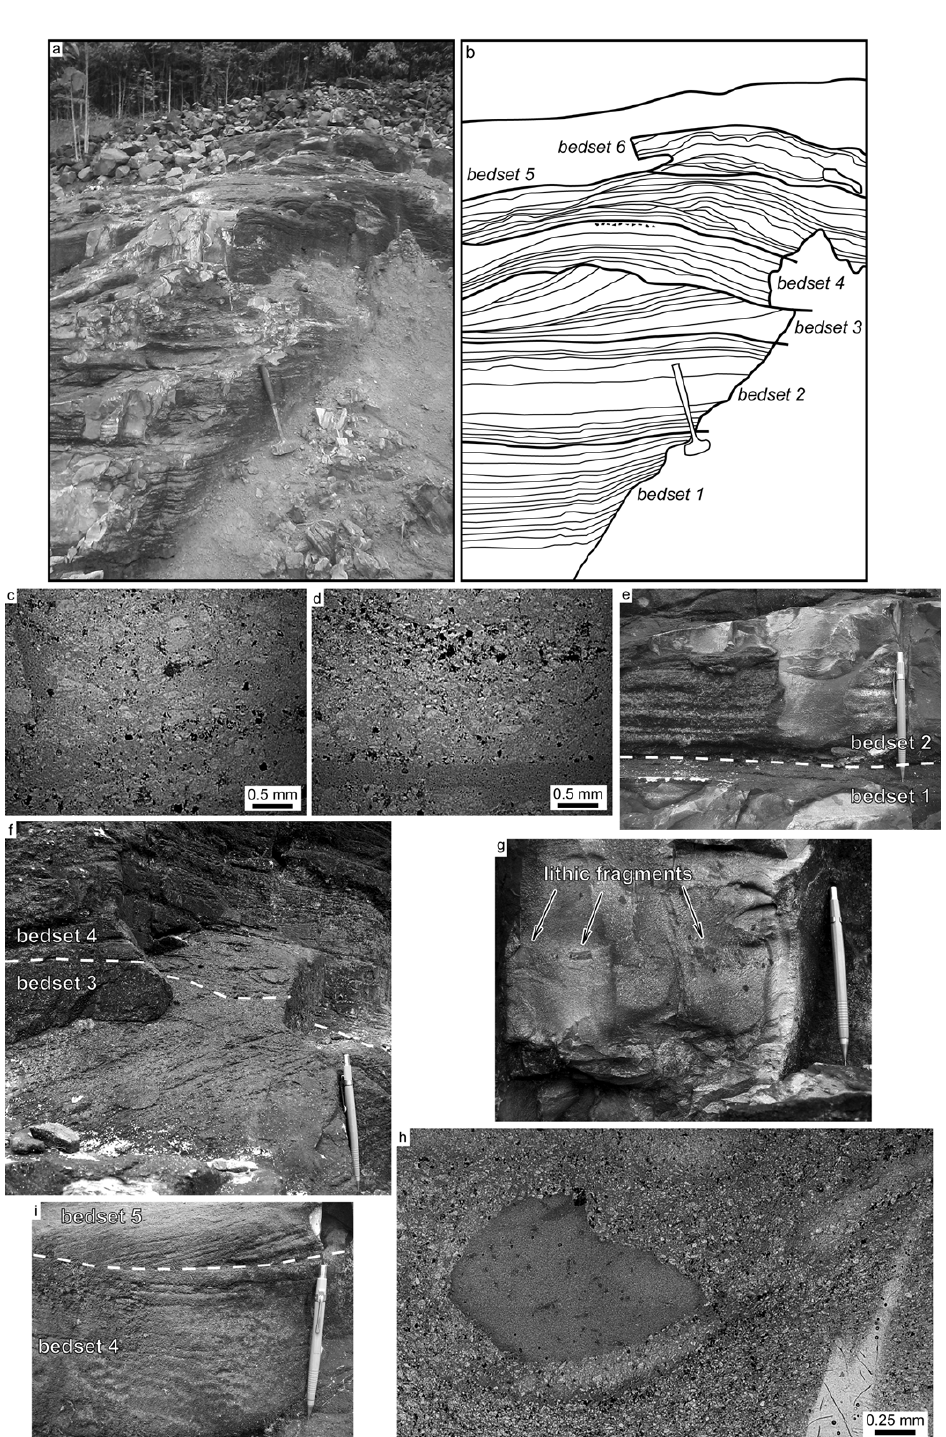
Fig. 3 – Field and petrographic characteristics of the surge deposits of the Iricoumé Group: a) outcrop A13 – see Figure 5 for location; b) Sketch of outcrop A13 showing the six bedsets; c) microscopic feature showing the dominant massiveness of co-ignimbritic deposits; d) internal organization ofthesurgedeposits; e)planeparallelstratificationinweatheredandfreshsurfaceclosetotheboundarybetweensets1and2; f)erosionalboundary between bedsets 3 and 4; g) level of lithic fragment close to the top of the bedset 4; h) tuffaceous cognate lithic fragment with dropping feature in thin section; i) low-angle truncation between bedsets 4 and